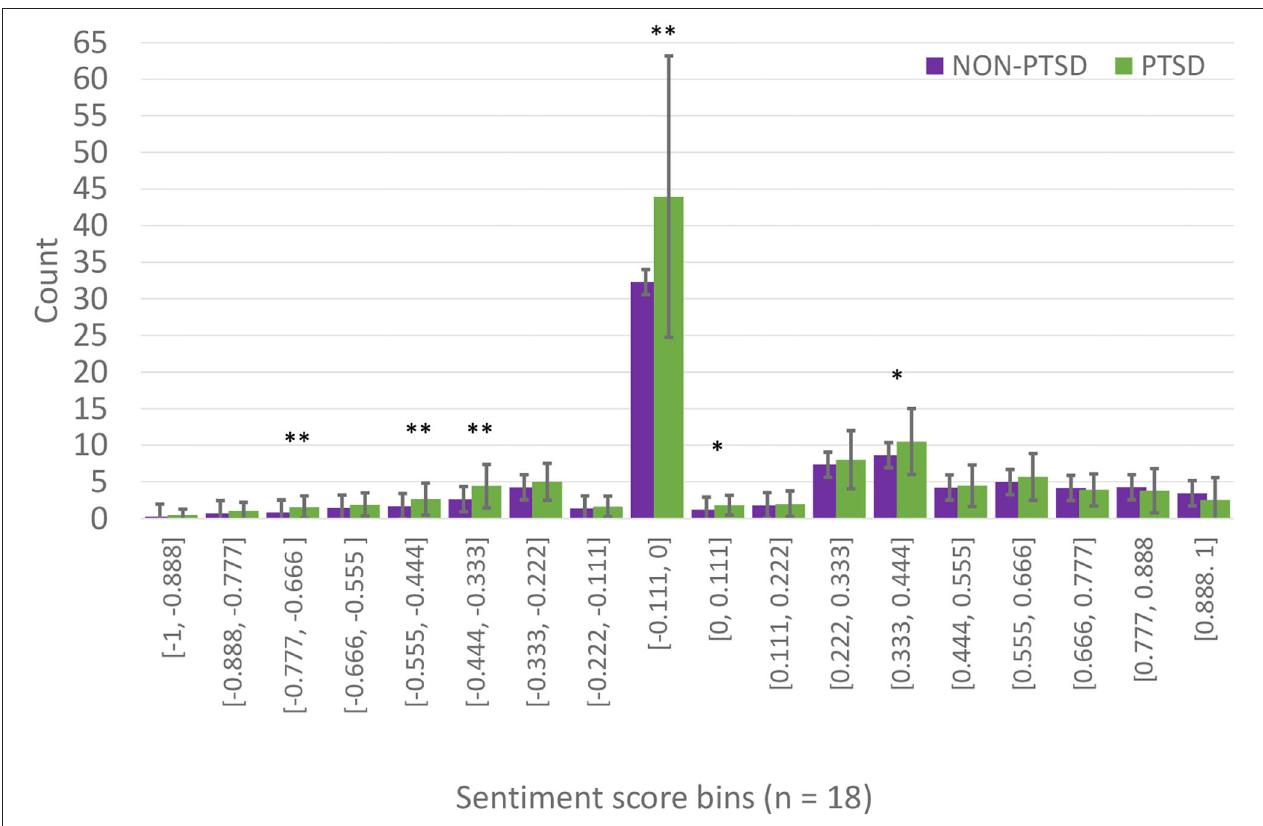
FIGURE 4 | Binned sentiment scores per group. These are the mean values of chosen binned sentiment scores (from the RF model in the five-fold-CV partition), in each bin, for both groups. The x-axis represents the bins and their sizes, and the y-axis represents the average number of utterances that fall within those sentiment scores for both PTSD and non-PTSD groups. Table 5 shows the means and standard deviations, and a one-way ANOVA was conducted to compare these values in each bin between the two groups. A Benjamini-Hochberg correction was made for 18 comparisons. The adjusted p -value threshold was set to p <0.00284. Error bars represent standard deviation. Significant difference denoted by * p <0.00284, ** p